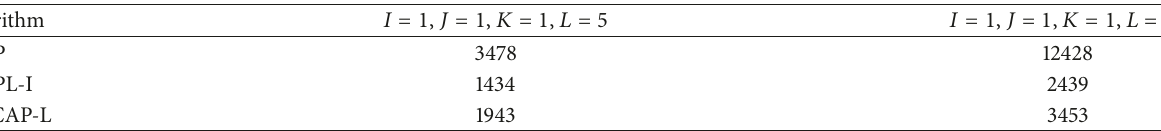
Table 4: Comparison of the computational burden of the FXECAP-L algorithm with those of the FXAP and FXAPL-I algorithms for ANC systems with 𝑁 = 100 and 𝑀 = 128 .